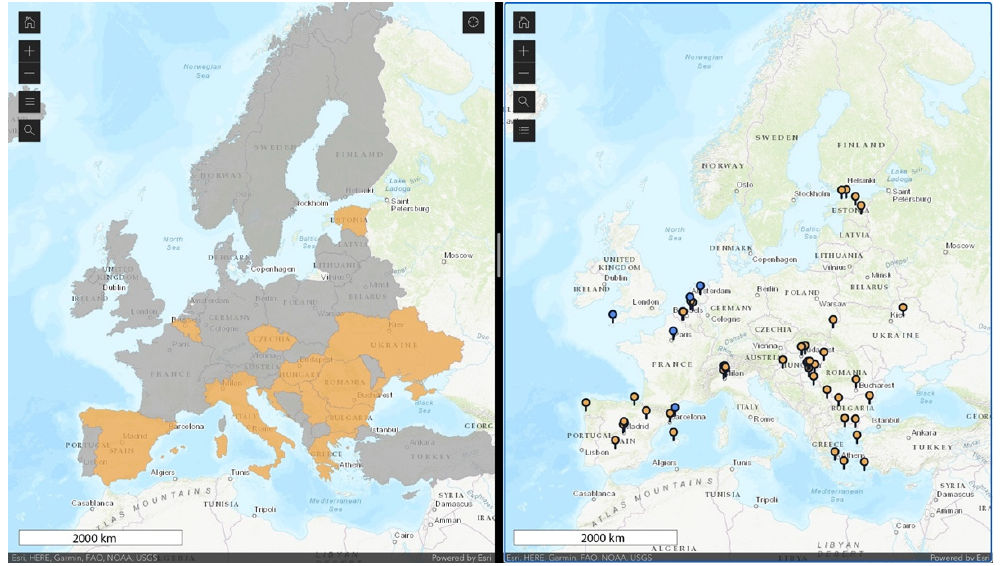
Figure 14. Country overview ( left ) and geothermal projects maps ( right ).